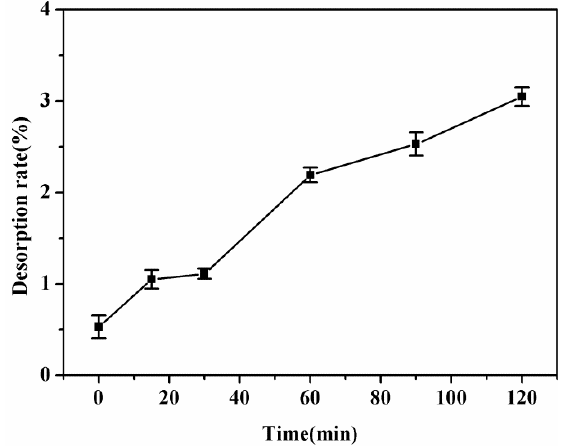
Figure 10. Regeneration of SPEN-CTAB-0% under a different strippant. Polymers 2019 , 11 , x FOR PEER REVIEW